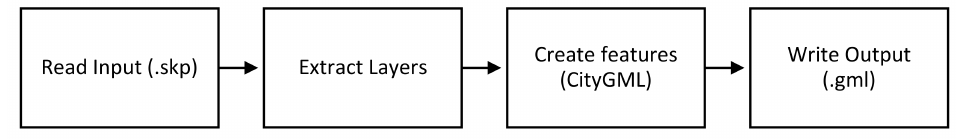
Figure 7. Data conversion processes executed in FME.